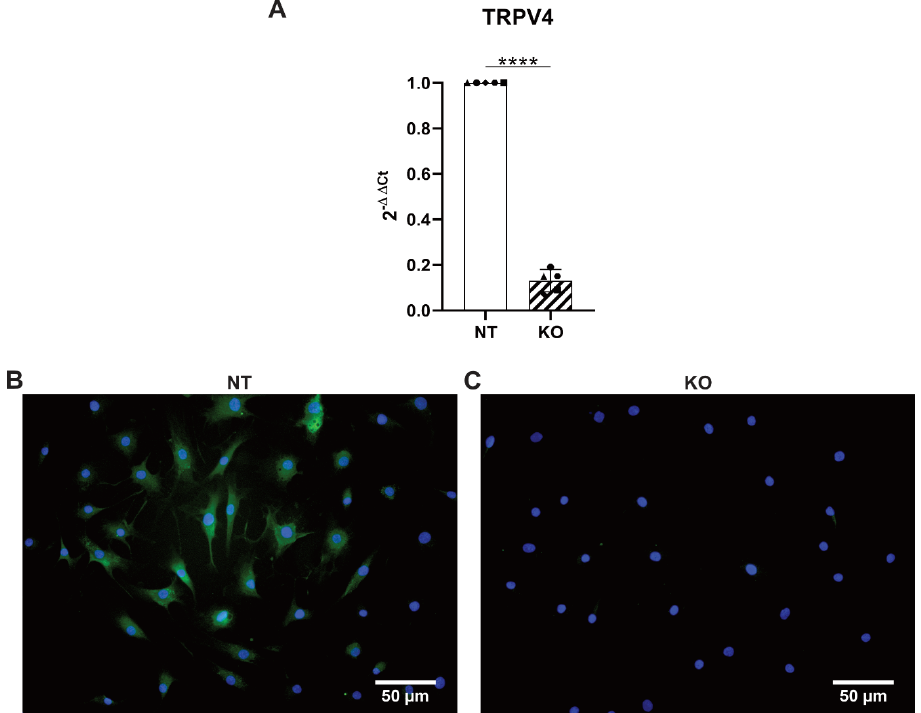
Figure 5. (A ) Gene expression of TRPV4 in the CRISPR-Cas9-transduced non-targeting control (NT, white bar) and the TRPV4 knockout (KO, hatched bar) cells. n = 5 donors; mean ± SD; **** p < 0.0001. Immunocytochemistry of ( B ) the NT and ( C ) the KO cells; green = TRPV4, blue = DAPI; scale bars = 50 µm.